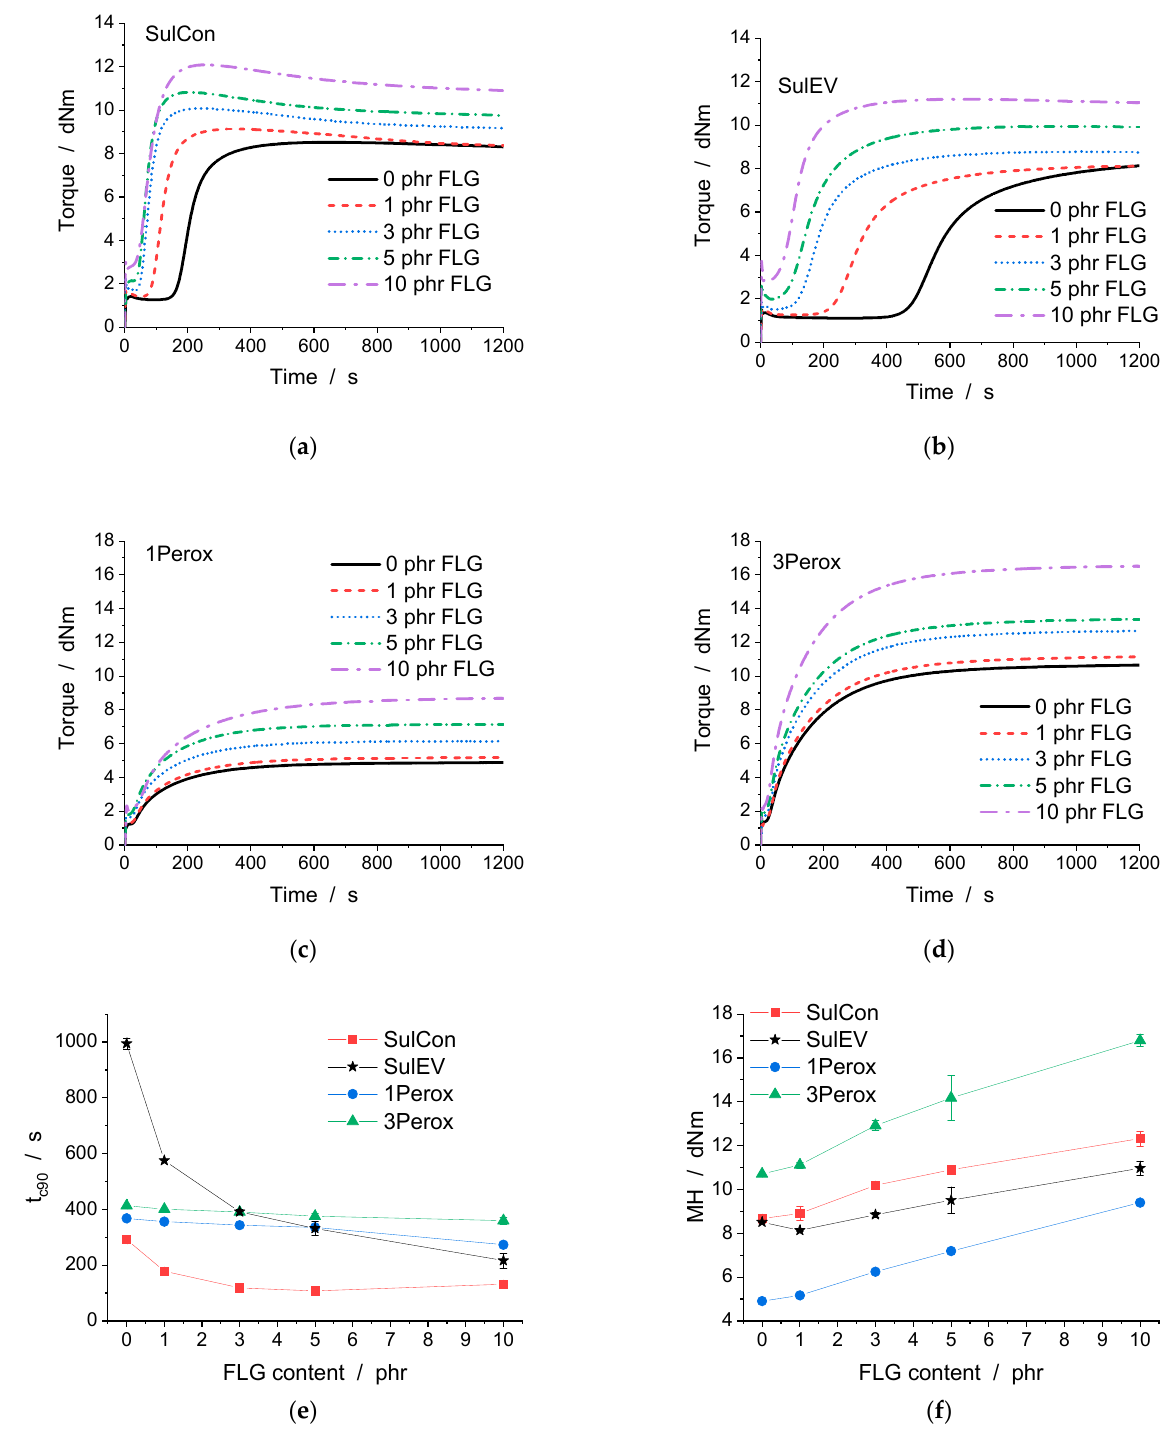
Figure 2. The vulcanization curves from MDR as torque over time are shown for ( a ) SulCon, ( b ) SulEV, ( c ) 1Perox, and ( d ) 3Perox with all FLG contents. Optimum curing time t c90 ( e ) and maximum torque MH ( f ) are displayed over FLG content.